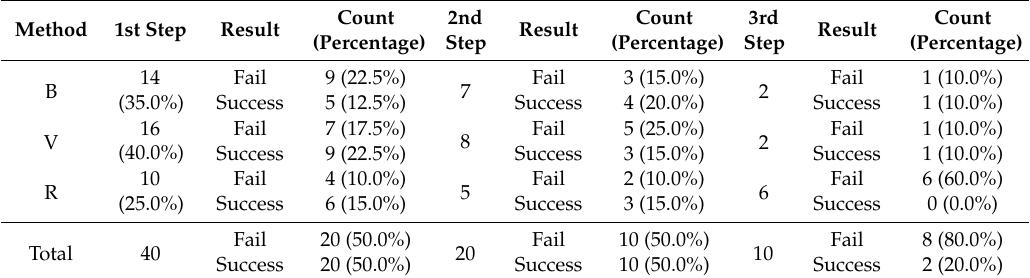
Table 3. The number of successes and failures for each of three intervention methods (remove biter: B; remove victim: V; give ropes: R) over 3 steps (percentages shown in brackets).